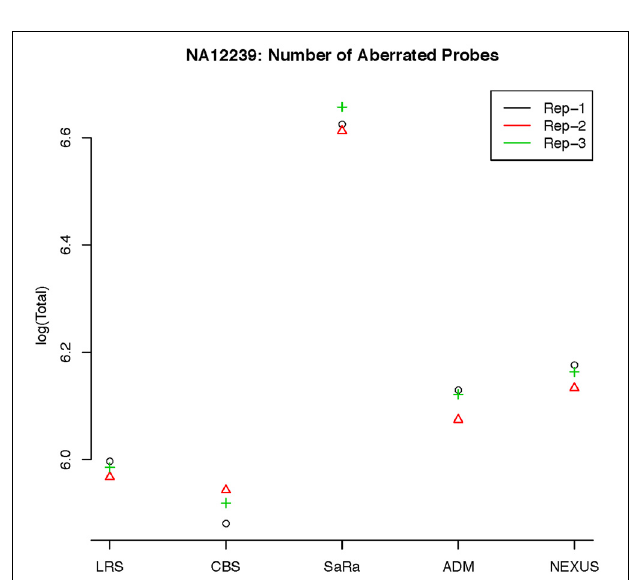
FIGURE 5 | log(Number) of unique CNV identified by each algorithm for HapMap sample NA18517 for each technical replicate. (Pinto et al., 2011) and 1.5 times the median absolute deviation, we can remove nearly all calls for this repetition. We use these thresholds to post-process calls for the rest of the samples.